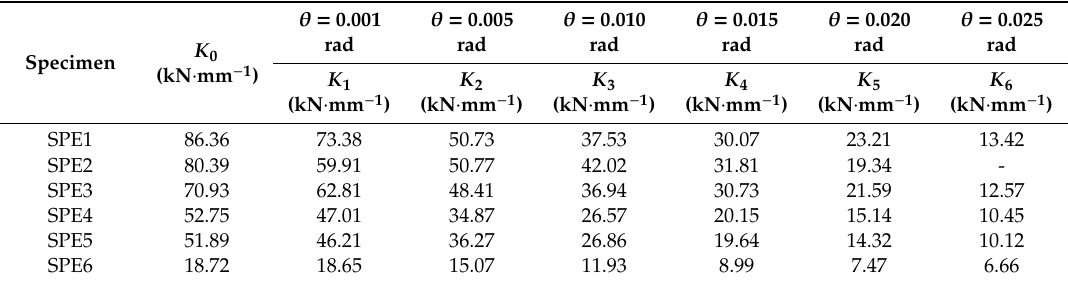
Figure 13. Sti ff ness degradation curves. Table 5. Values of sti ff ness on main